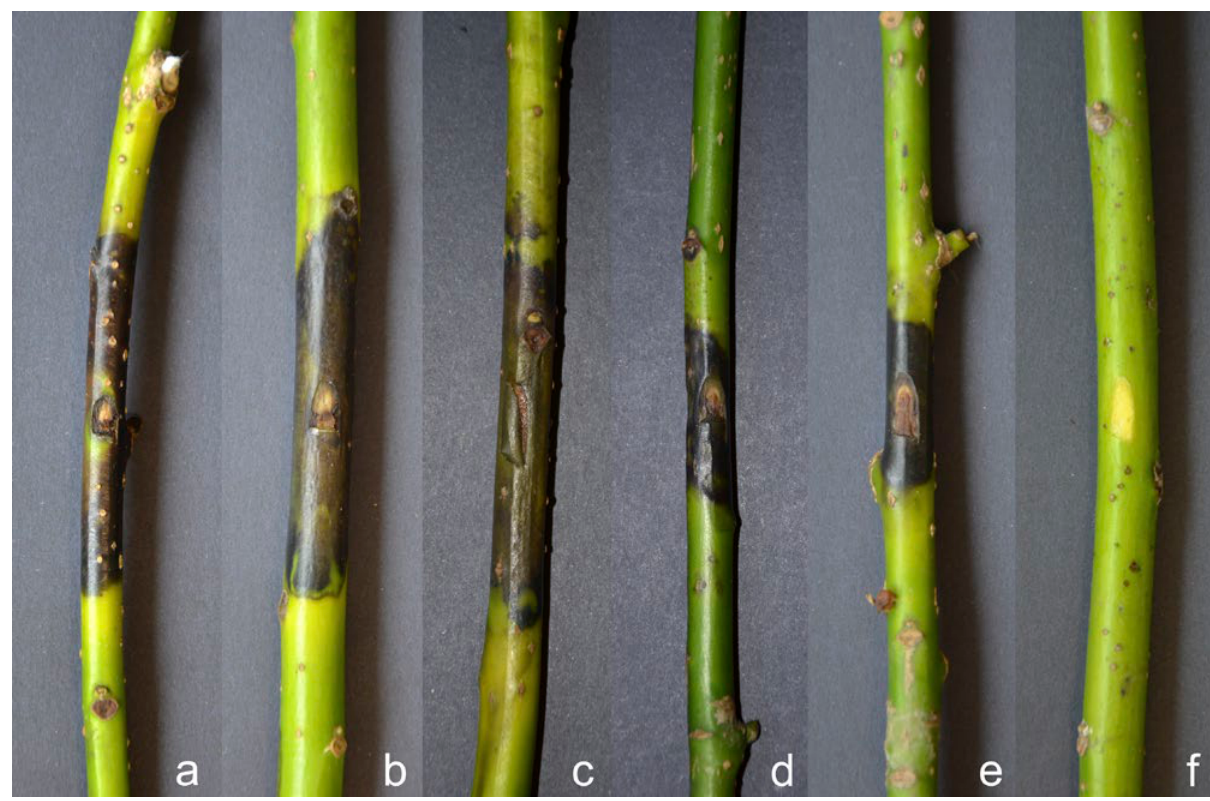
Figure 4. Necrotic lesions developed on inoculated twigs of Ilex aquifolium after 2 weeks. Phytophthora ilicis isolate PH046 (a), PH161 (b), PH136 (c), P1900 (d), P1567 (e) and control